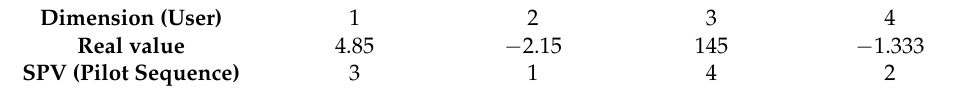
Table 1. Example of operation of SPV in a single cell, K = 4 users